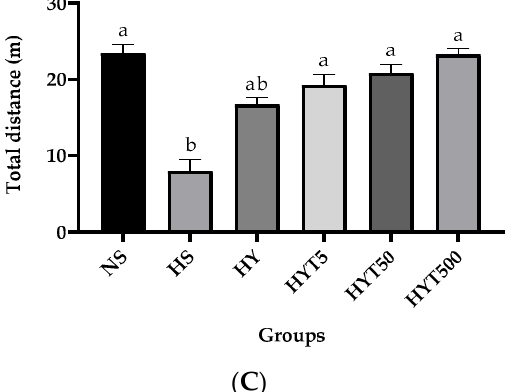
Figure 3. ( A ). Time spent at the thigmotaxis by the female offspring in open field test. ( B ). Time spent at the central zone by the female offspring in open field test. ( C ). The total distance traveled by the female offspring in the central zone of open field test. NS: normal chow and saline; HS: HFD and saline; HY: HFD and yoghurt; HYT5: HFD and 5 mg/kg of E. tapos yoghurt; HYT50: HFD and 50 mg/kg of E. tapos yoghurt; HYT500: HFD and 500 mg/kg of E. tapos yoghurt. Values are expressed as mean ± SEM. Different letters indicate a significant difference at p < 0.05.